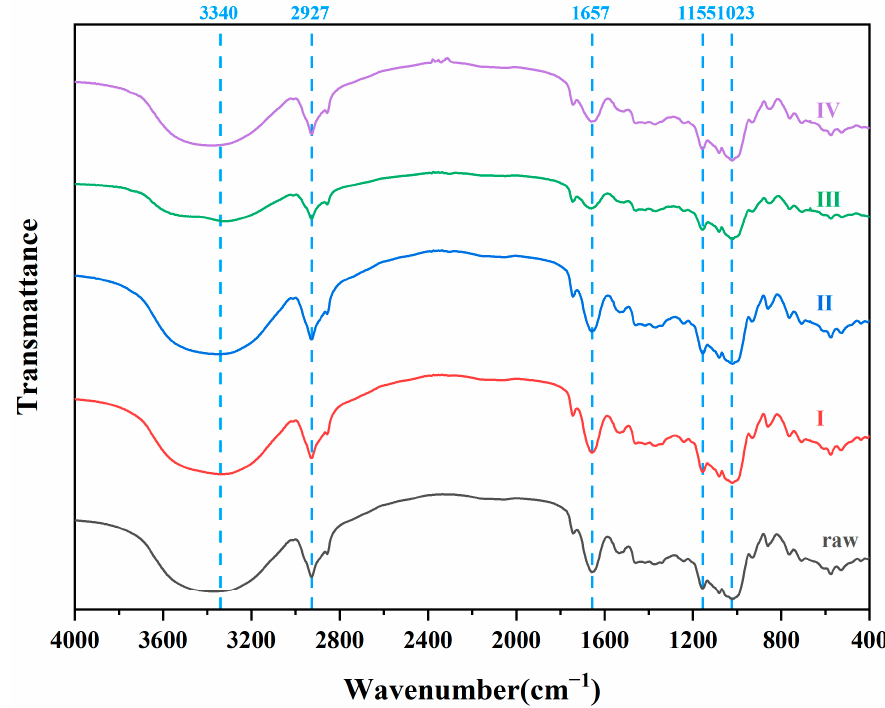
Figure 3. FTIR patten of oats from different zones at 20% moisture. Raw: native oat; I: oat in mixing zone; II: oat in cooking zone; III: oat in melting zone; Ⅳ : extrudate.